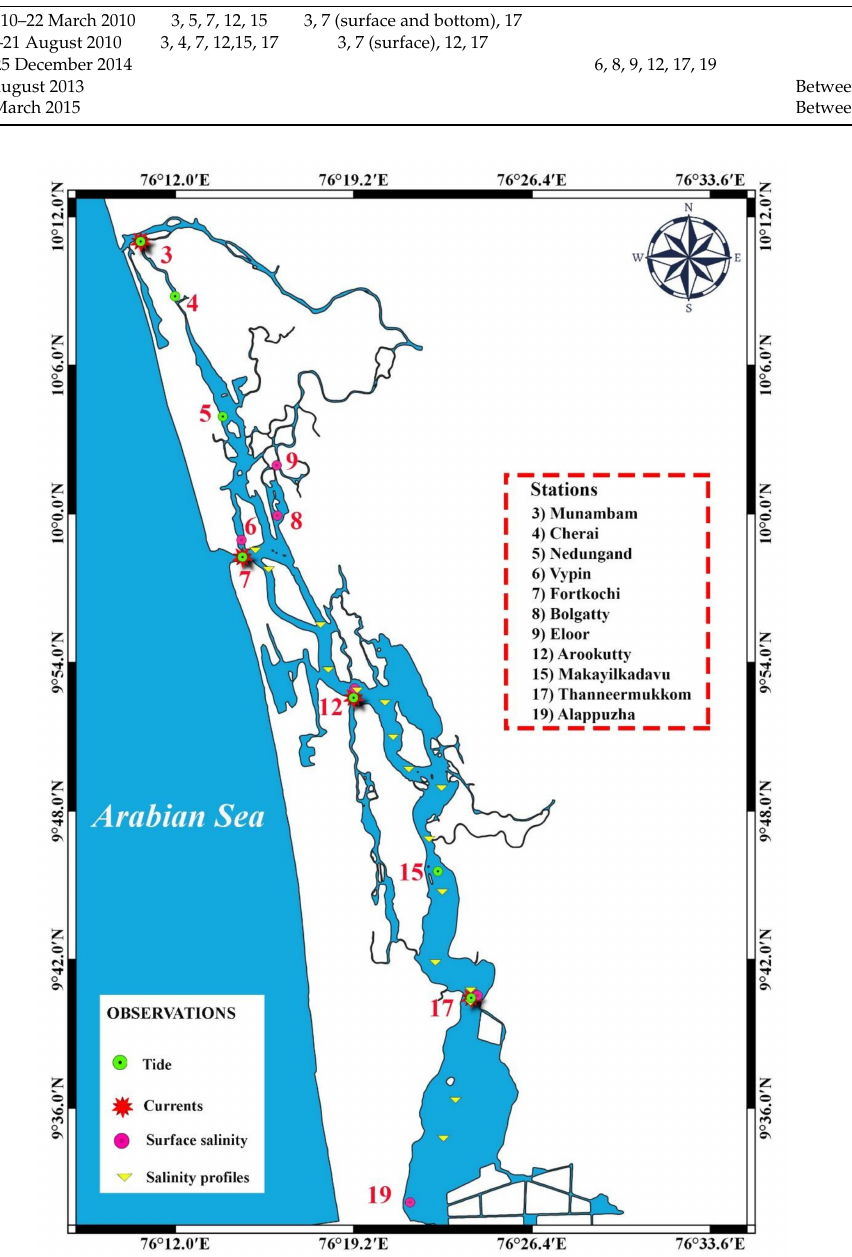
Figure 4. Sampling locations for model validations (tides, currents and